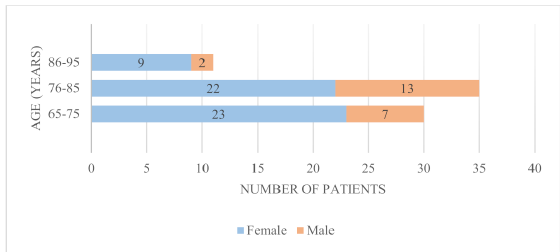
Figure 1. Sex and age distribution of patients included in the